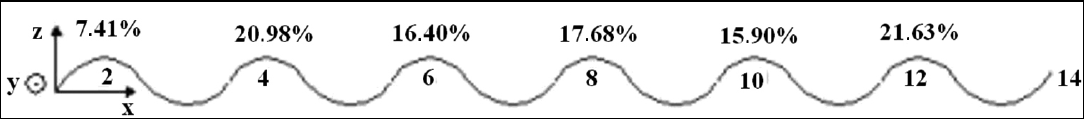
Figure 5. Load of 2500 N/m applied in fractions of the total load in the high waves 2, 4, 6, 8, 10 and 12 in the central strip of width equal 230 mm.